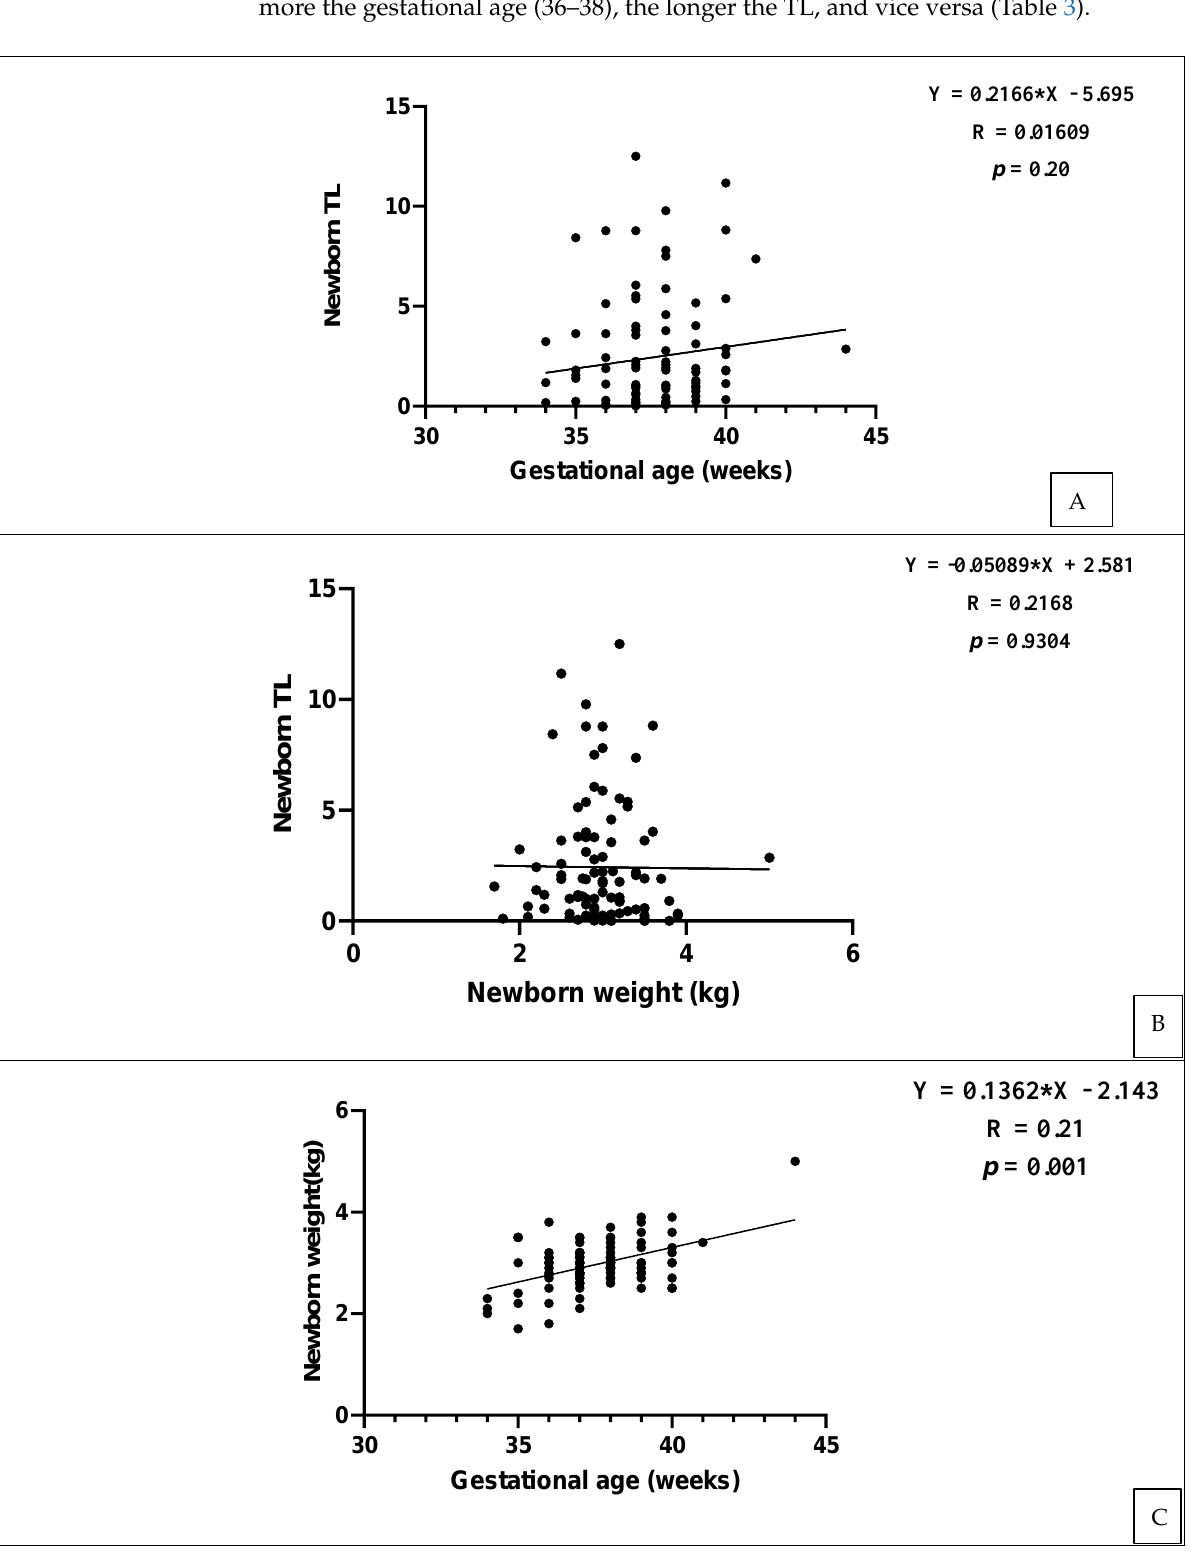
Figure 4. ( A – C ) Association between newborn telomere length (TL) and gestational age and birth weight. There was no association between newborn weight and gestational age, but there was a positive association between gestational age and newborn weight.